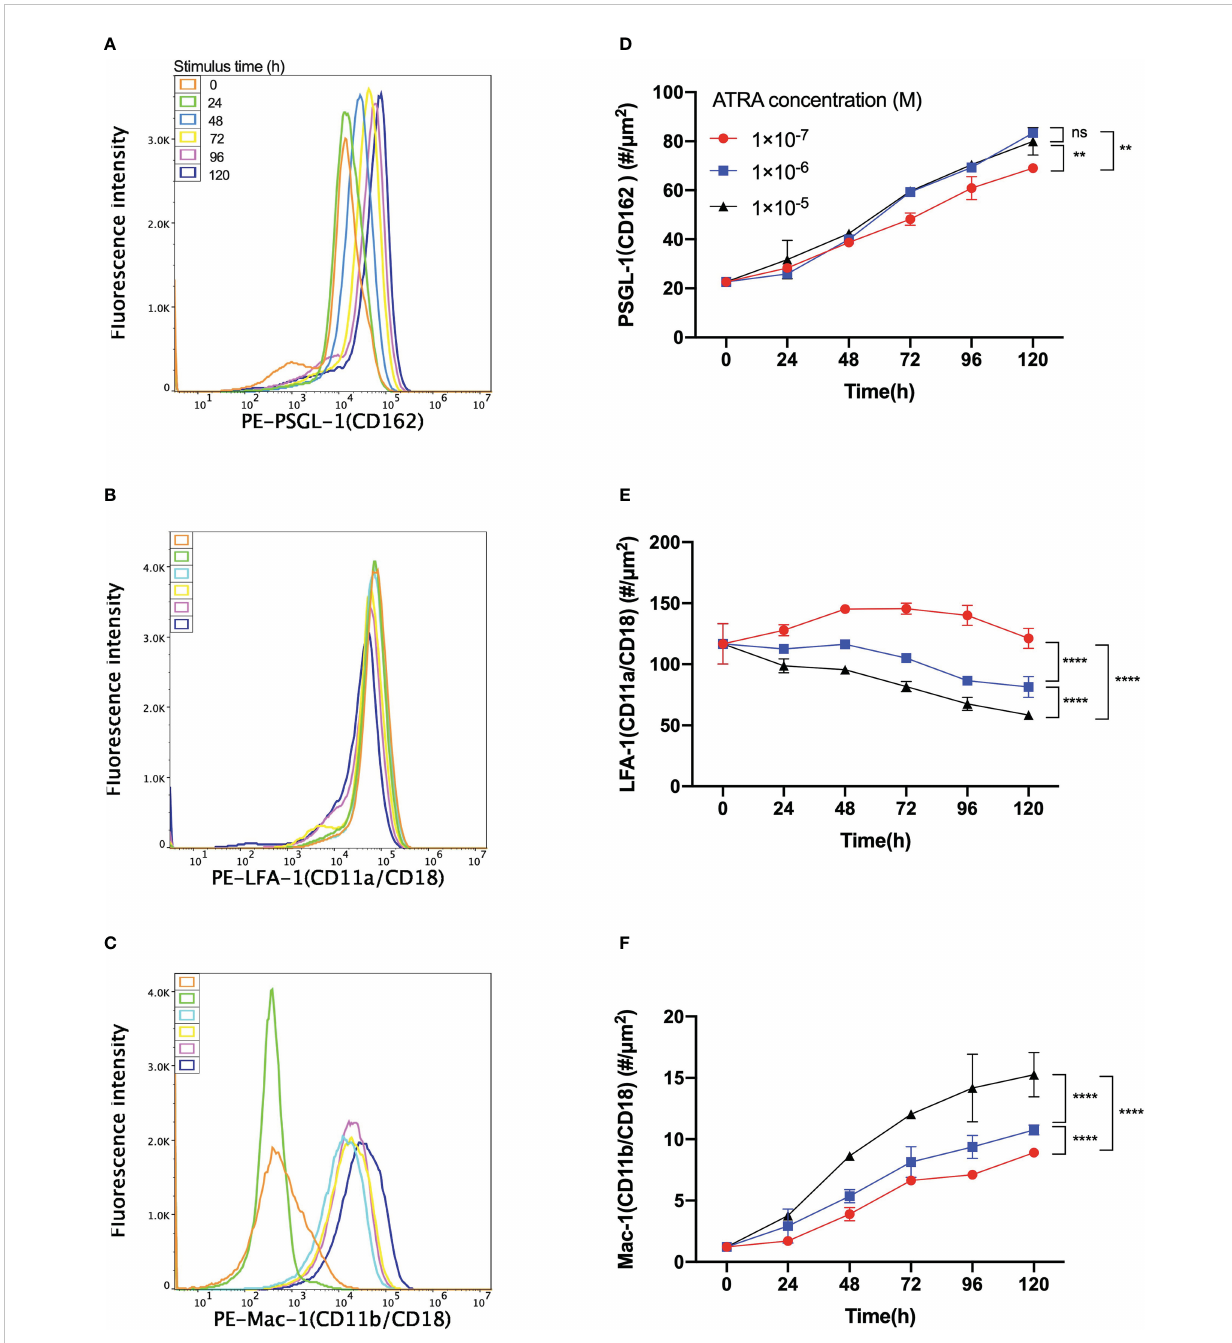
FIGURE 2 Variation of the expression level of PSGL-1, LFA-1, or Mac-1 on all-trans retinoic acid (ATRA)-treated HL60 cells versus the agent dose and stimulus time. Fluorescence intensity patterns of (A) PSGL-1 or CD162, (B) LFA-1 or CD11a/CD18, and (C) Mac-1 or CD11b/CD18 on HL60 cells with 1 × 10 -6 M ATRA treatment for stimulus times of 0 h (orange), 24 h (green), 48 h (light blue), 72 h (yellow), 96 h (purple), and 120 h (blue). All three patterns came from using a fl ow cytometer. Plots of the molecular density site of (D) PSGL-1, (E) LFA-1, and (F) Mac-1 on HL60 cells with treatments of 1 × 10 -7 M (red), 1 × 10 -6 M (blue), and 1 × 10 -5 M (black) ATRA against stimulus time. The data were derived from the linear fi tting formula MFI = 1.82 × r - 299, with fi tting degree r 2 = 0.999, where MFI denoted the fl uorescence intensity and r was the molecular density site (#/µm 2 ), and # was the molecule number. Three independent experiments were carried out, and the data were shown as mean ± SD. Statistical signi fi cance was analyzed by two-way ANOVA followed by Tukey ’ s multiple-comparisons tests, and the signi fi cant level of difference was shown by the P -value. ** P < 0.01, **** P < 0.0001, and ns means no signi fi cant